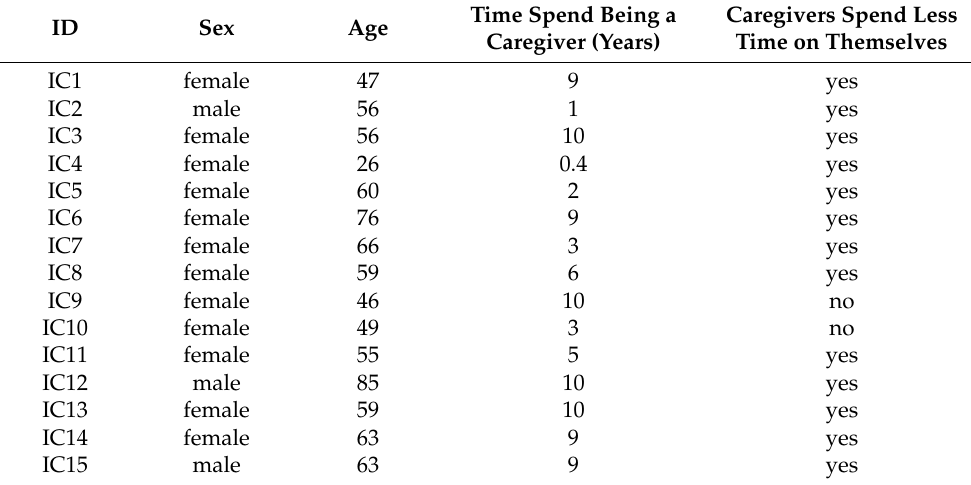
Table 1. Socio-demographic data of participants.